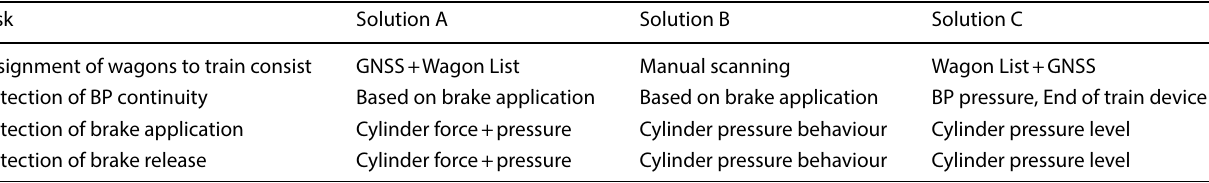
Table 1 Comparison of different published solutions. Solution A : PJM product [7]. Solution B : approach described in [8]. Solution C : approach described in [9] Task Solution